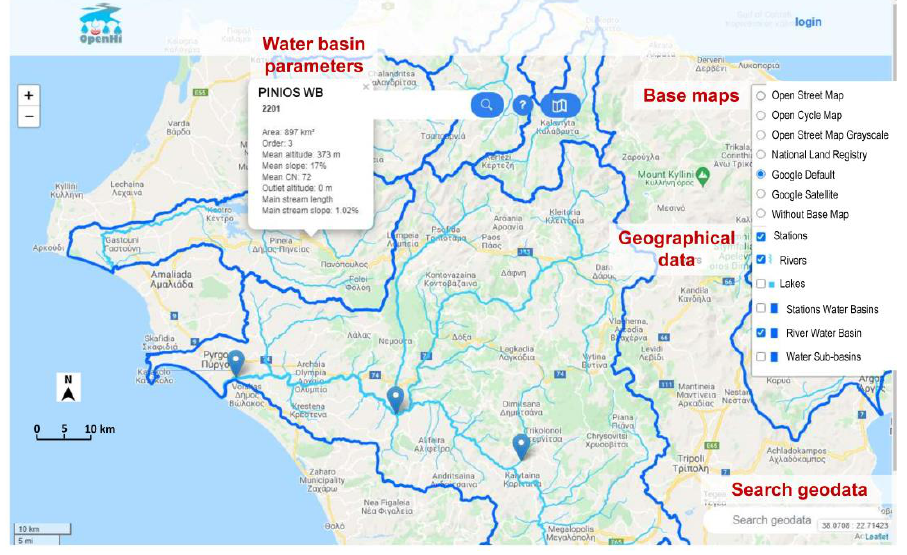
Figure 2. Application for geographical data handling.